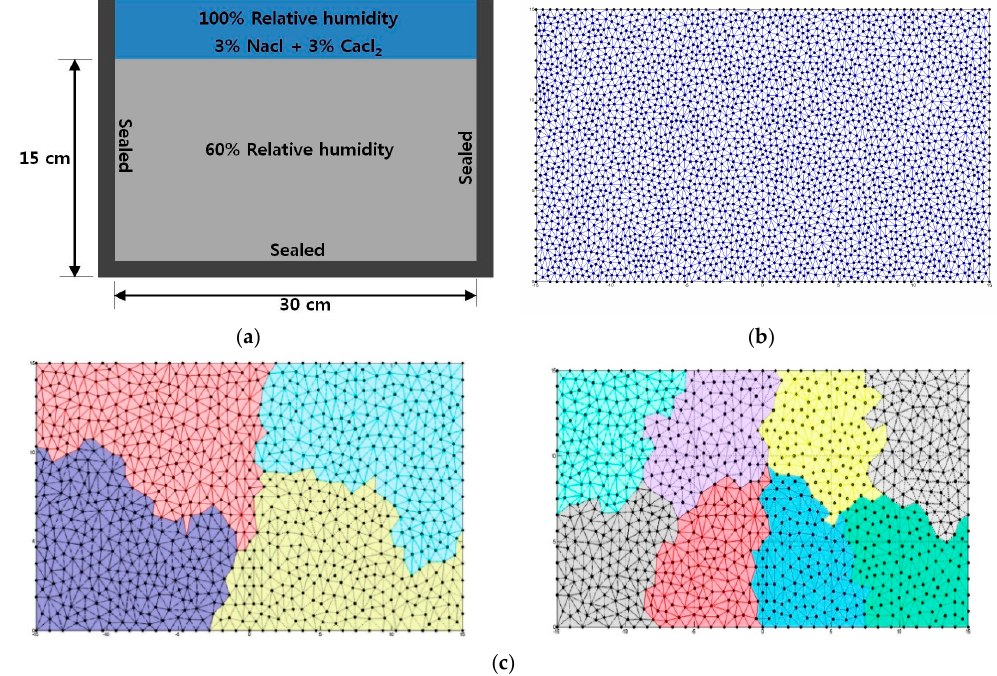
Figure 7. Numerical simulation model and partitioning meshes. ( a ) Geometry information; ( b ) Mesh generation; ( c ) Partitioning meshes with 4 and 8 processors.